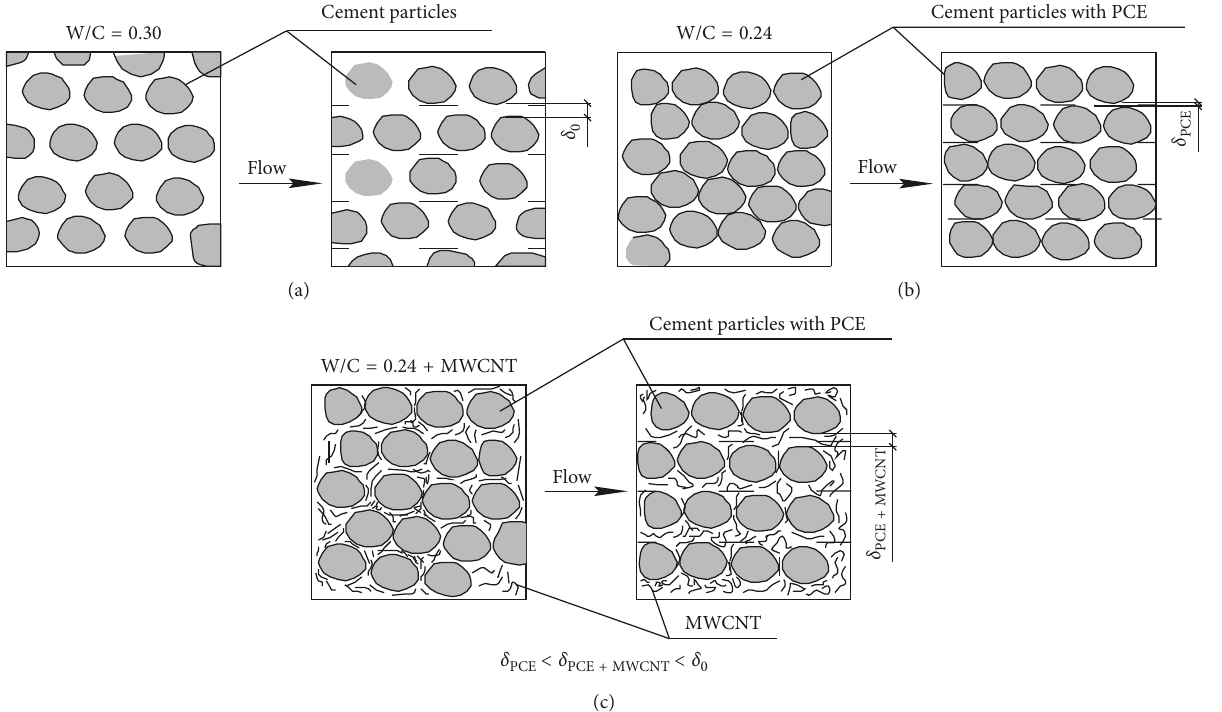
Figure 17: Flow behavior of cement pastes: (a) Without PCE. (b) With PCE. (c) With PCE and MWCNT